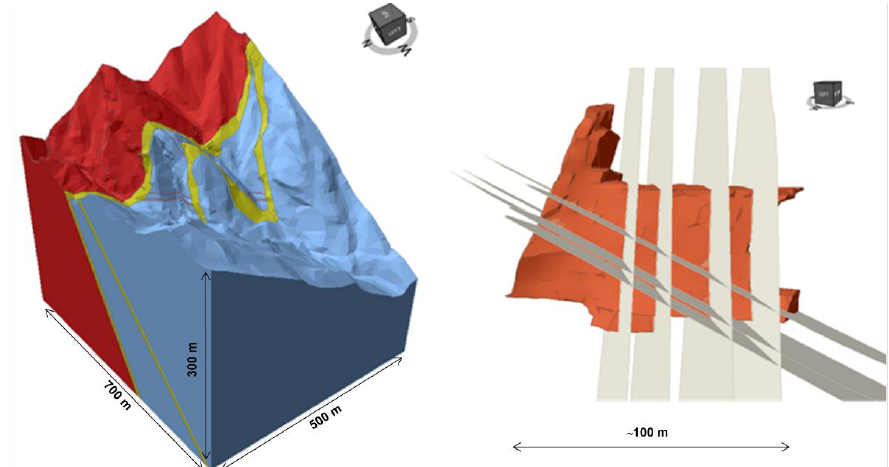
Figure 8. 3D geological model of the Sottovettolina quarry used in slope stability analysis (left); lithologies are indicated by colors, as follows: red = cherty meta-limestone; yellow = radiolarian chert; light blue = marble. Detail of discontinuity planes affecting the cultivation chamber (right). Perspective views; the scale bars are indicative only.